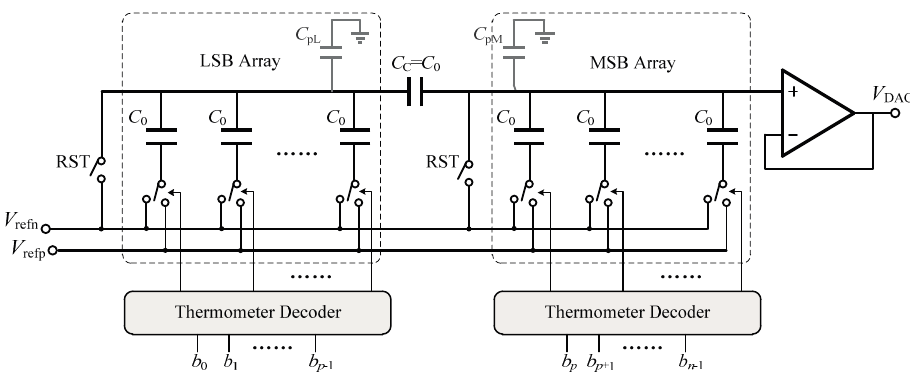
Figure 9. DAC based on the unary-weighted split-capacitor